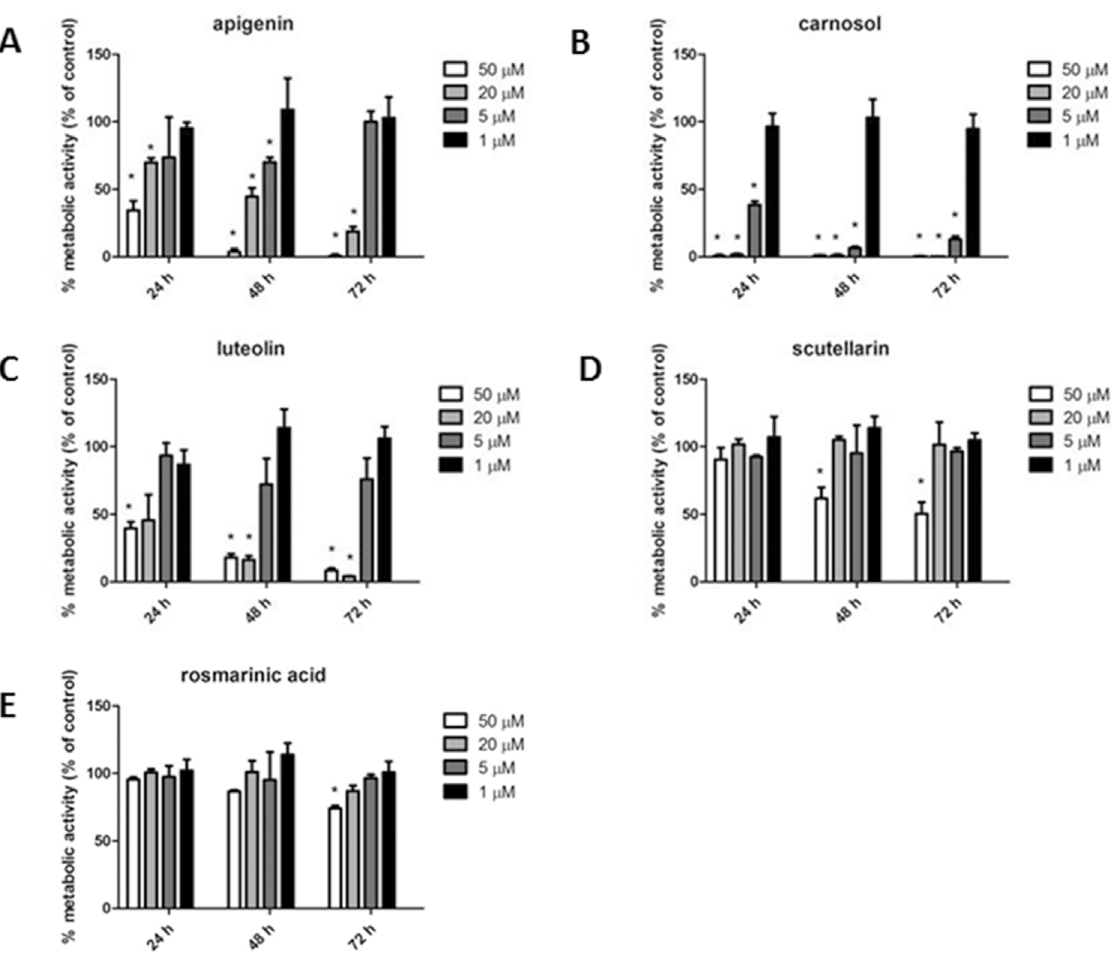
Fig 3. Effect of apigenin (A), carnosol (B), luteolin (C), scutellarin (D) and rosmarinic acid (E) on metabolic activity of A375 melanoma cells, assayed by MTT assay. Data are expressed as % of cell survival with respect to control. Results are the mean ± SD from three independent experiments. * P (cid:1) 0.05 versus vehicle